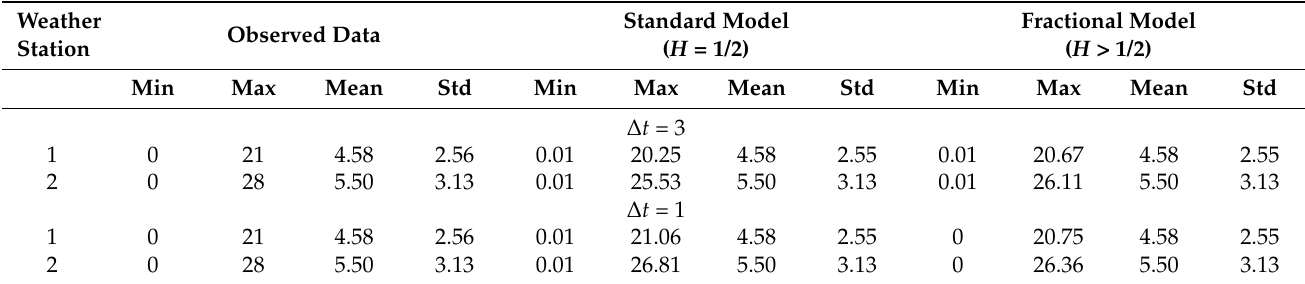
Table 2. Descriptive statistics of real and simulated wind speed data.